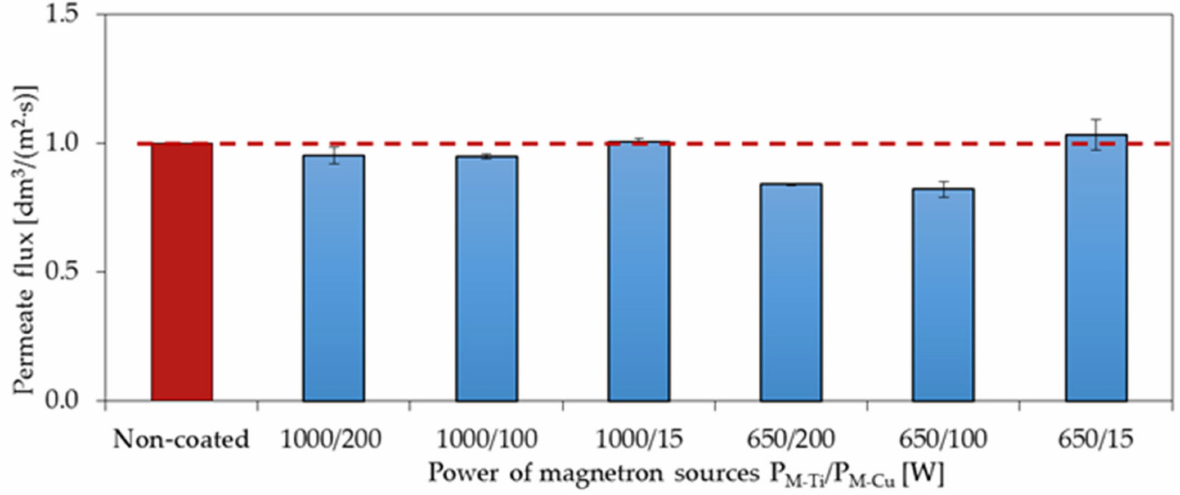
Figure 11. The effect of changing the magnetron power P M-Ti and P M-Cu in the deposition process of the TiO 2 + CuO coatings on the membrane surface on the permeate flux determined during filtration.